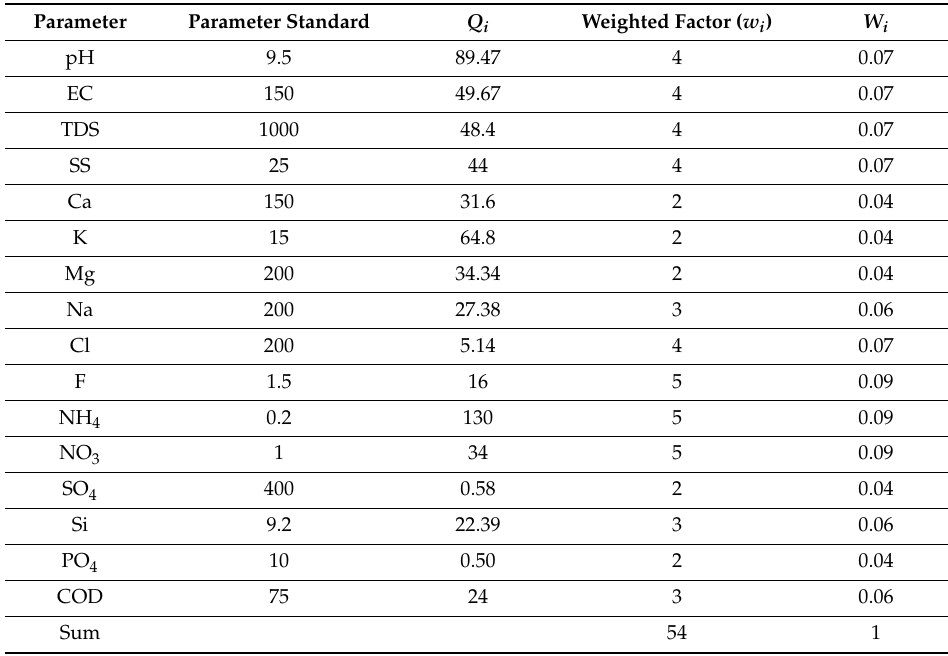
Table 1. The relative weight of chemical